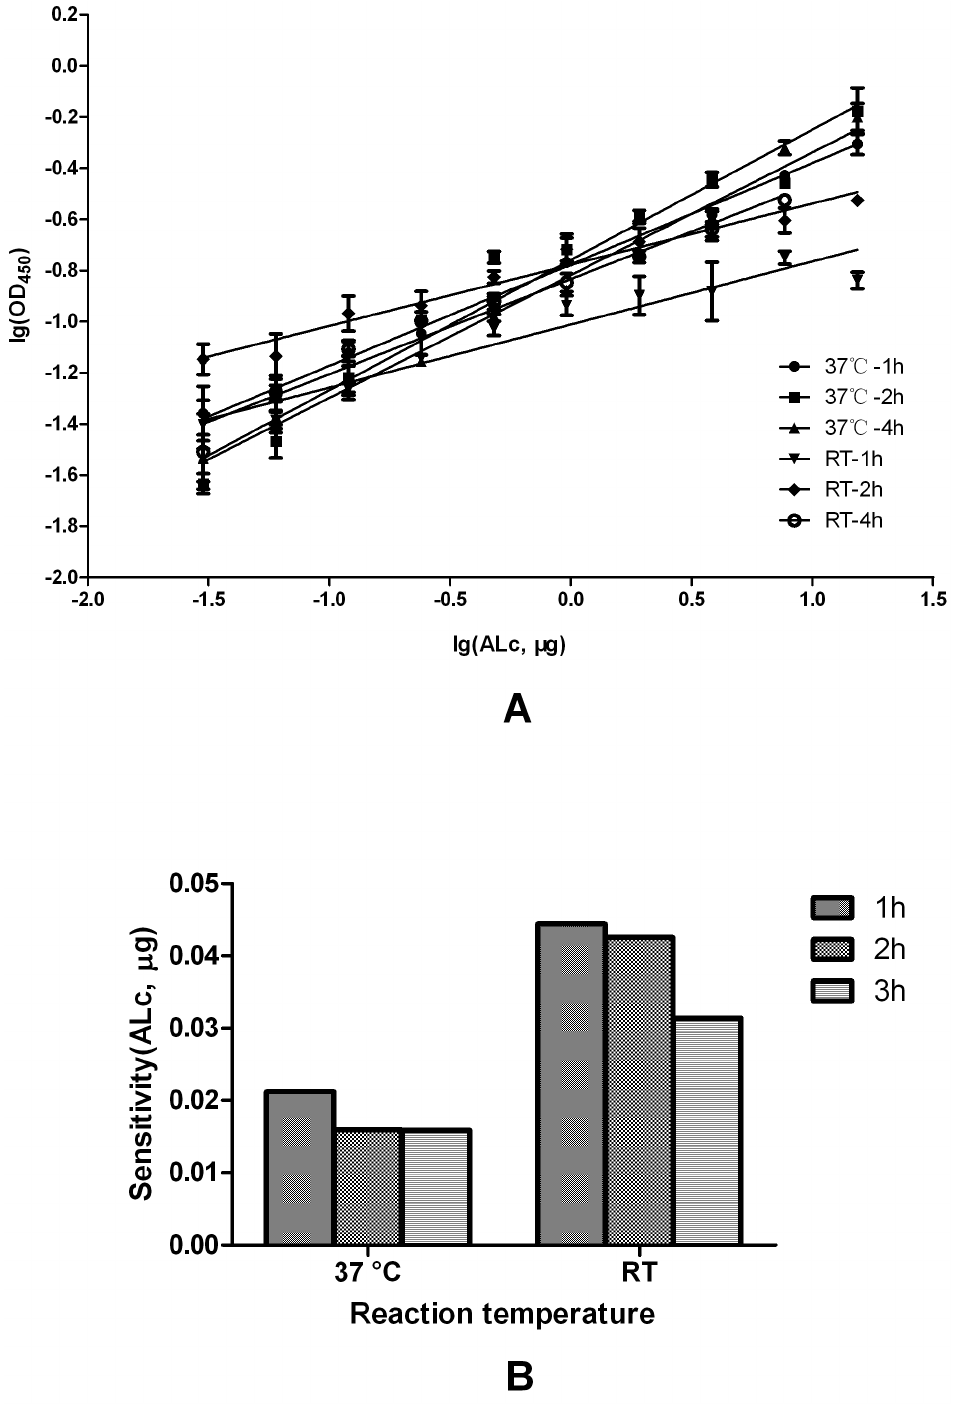
Figure 4. Effects of temperature and time in the ALc endopeptidase assay. A) Concentration–response relations between OD 450 and ALc with different reaction temperatures and time combinations. B) Sensitivity of the endopeptidase assay at different temperature and time combinations.